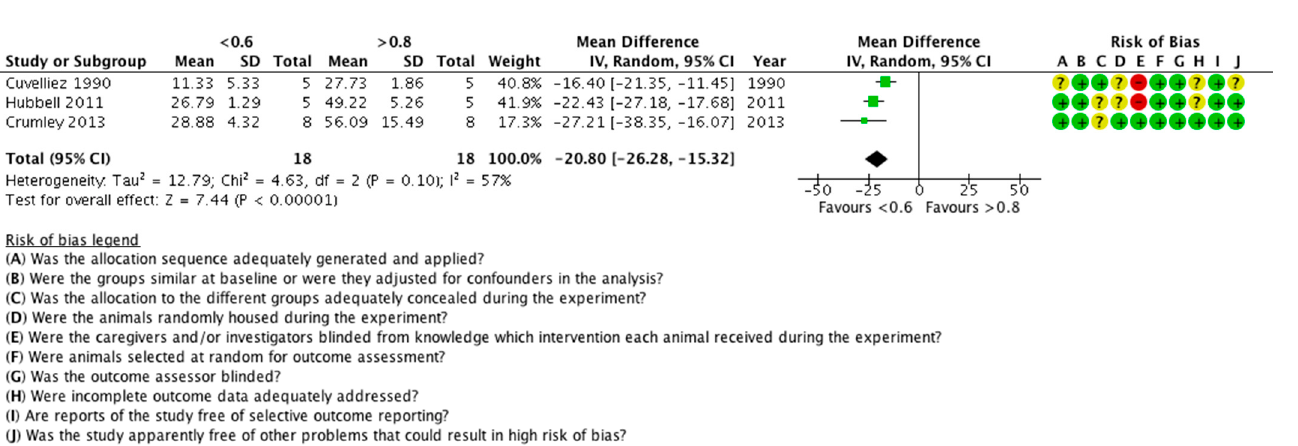
Figure 5. Forest plot of the effect of F I O 2 on P( A -a)O 2 . Units are in kPa. CI: confidence interval; IV: inverse variance; SD: standard deviation. ?: unclear risk; -: high risk; +: low risk.